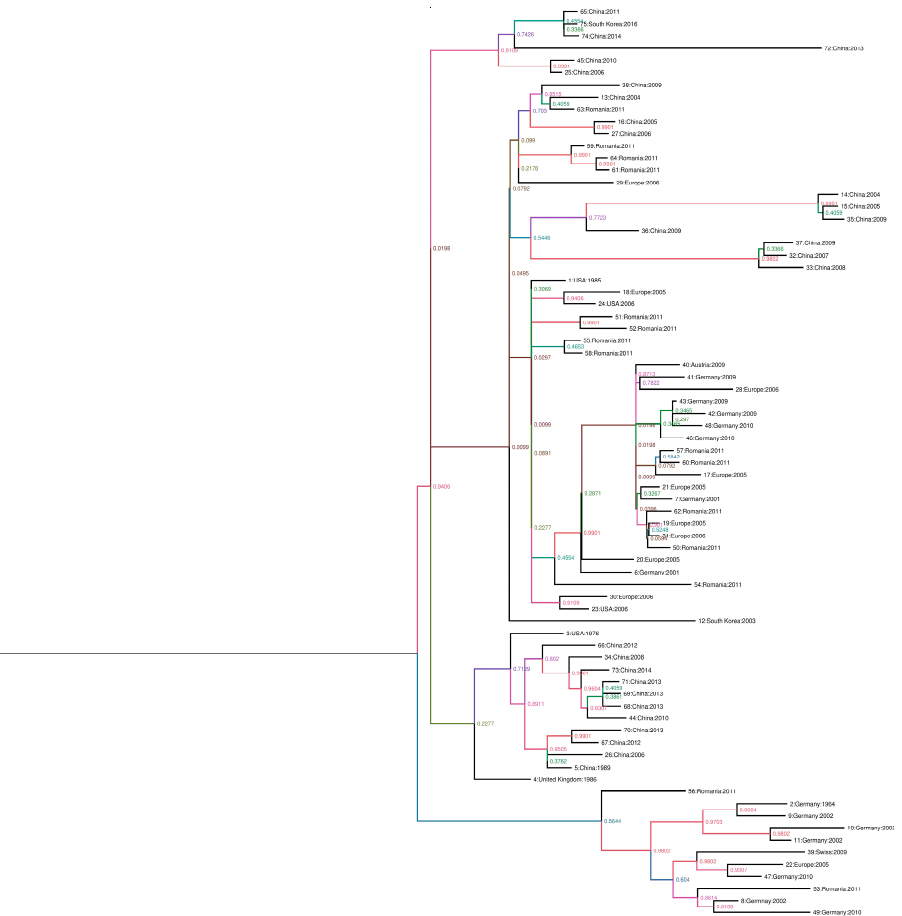
Figure 1. Phylogenic trees created with the non-structure protein gene ( NS1 ), viral protein gene ( VP1 ), and major structural protein ( VP 2) sequences. The scale axis indicates the distance in years and posterior probabilities are indicated according to the color of the branches. The phylogeny was estimated using the Bayesian continuous-time Markov chain (CTMC) method with Beast version 1.8.2. The phylogenic tree was visualized and edited using FigTree version 1.4.2, in the following